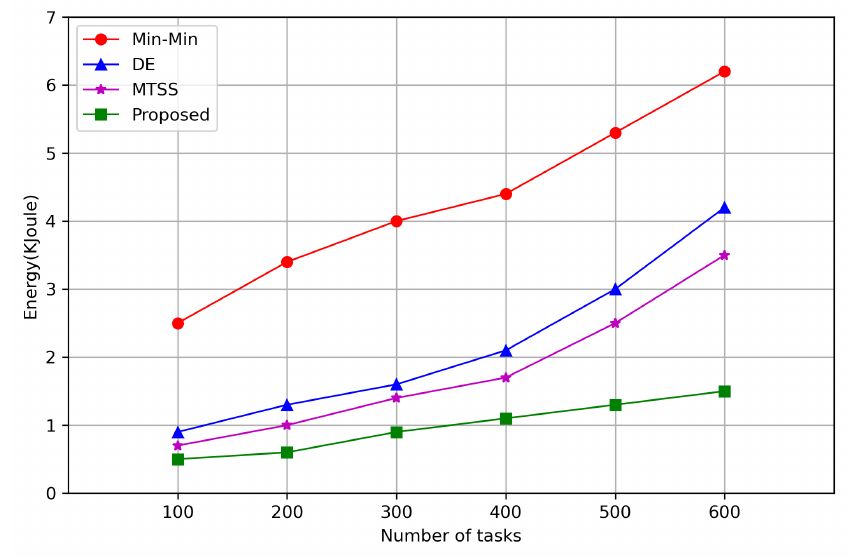
Figure 20. Performance evaluation of average energy with a number of